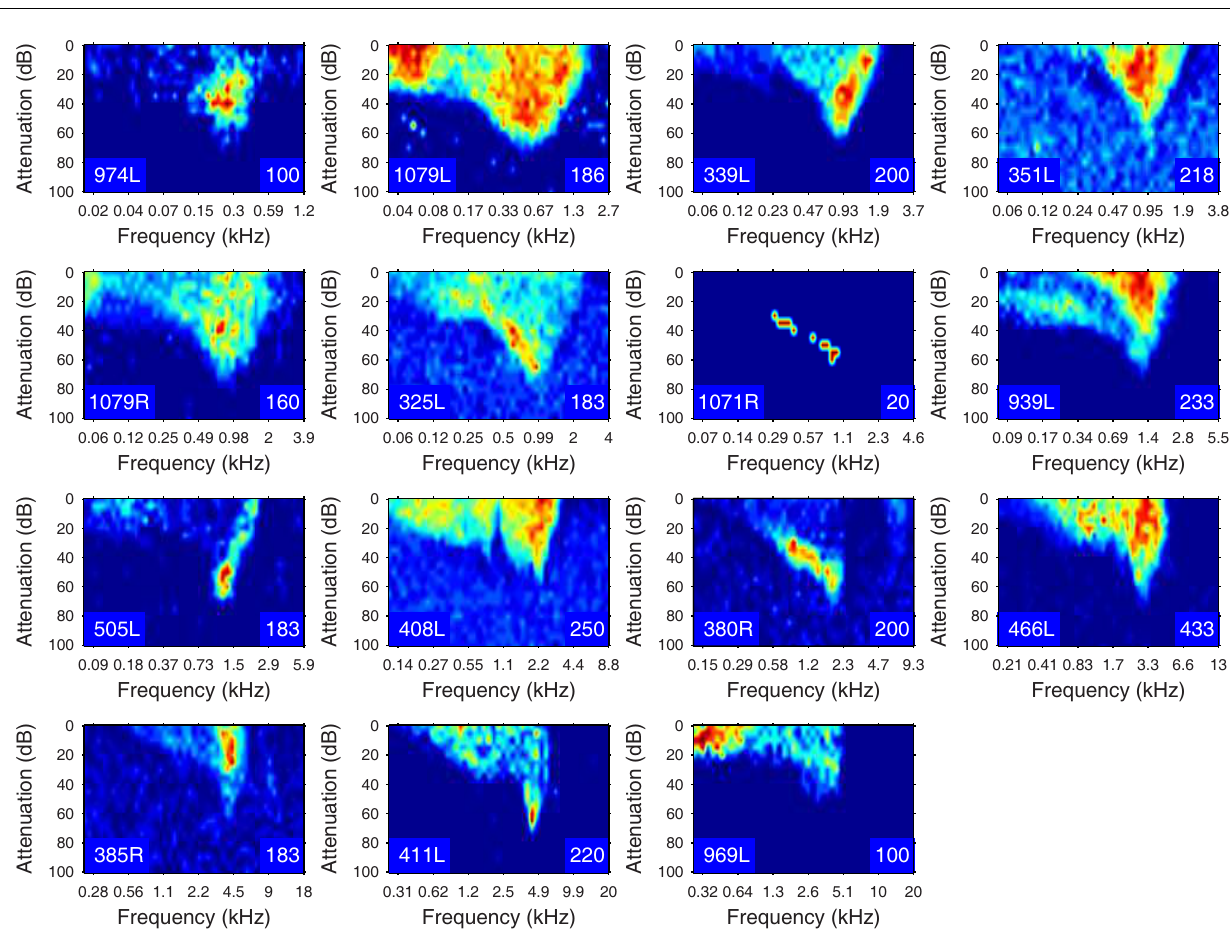
FIGURE 9 | Frequency response areas (see “Materials and Methods”) for the 15 filled cells. The topographic arrangement follows the previous figures and is tonotopic.The response areas are normalized on a temperature scale